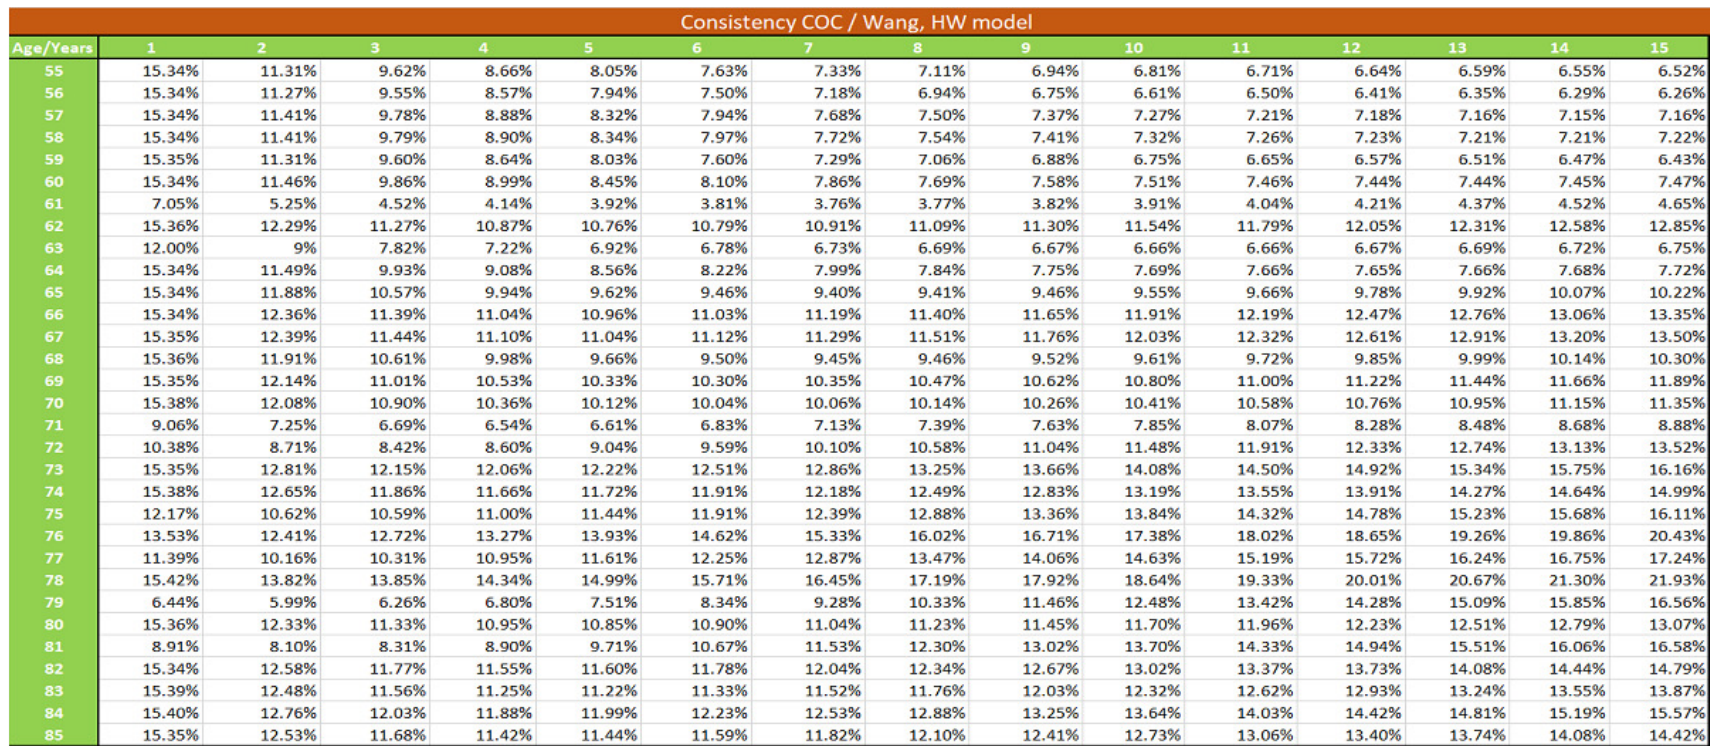
Figure A4. Consistency between Sharpe and Cost of Capital method, HW